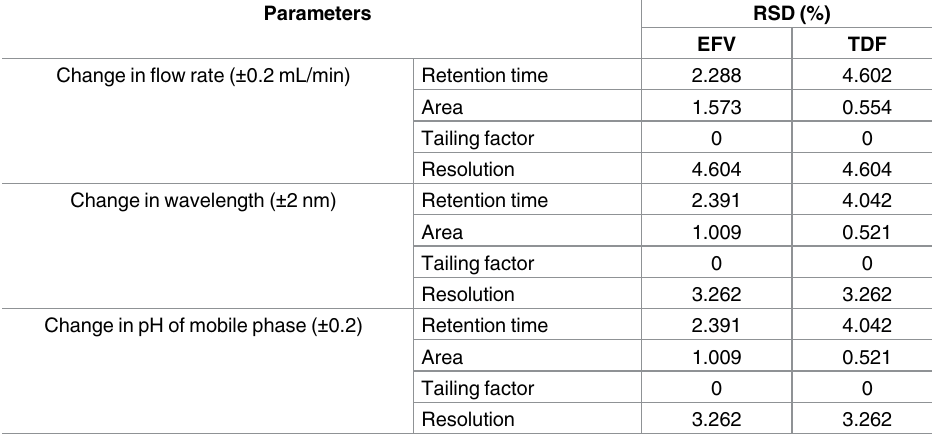
Table 4. Robustness data for change in different